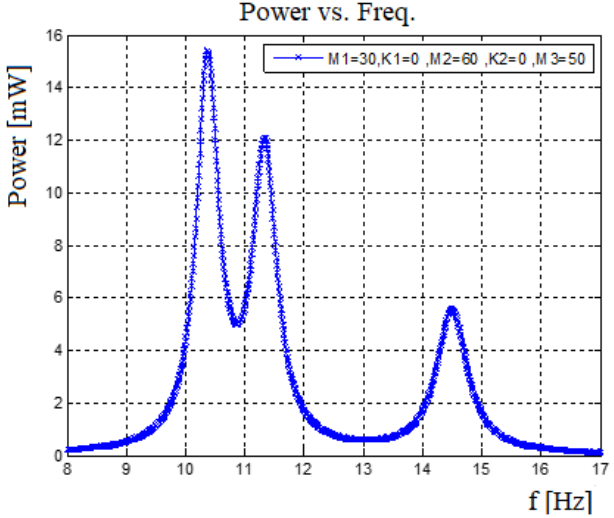
Figure A8. Power output for no spring connections ( K 1 = K 2 = 0)—three bimorphs interconnected by two springs case.